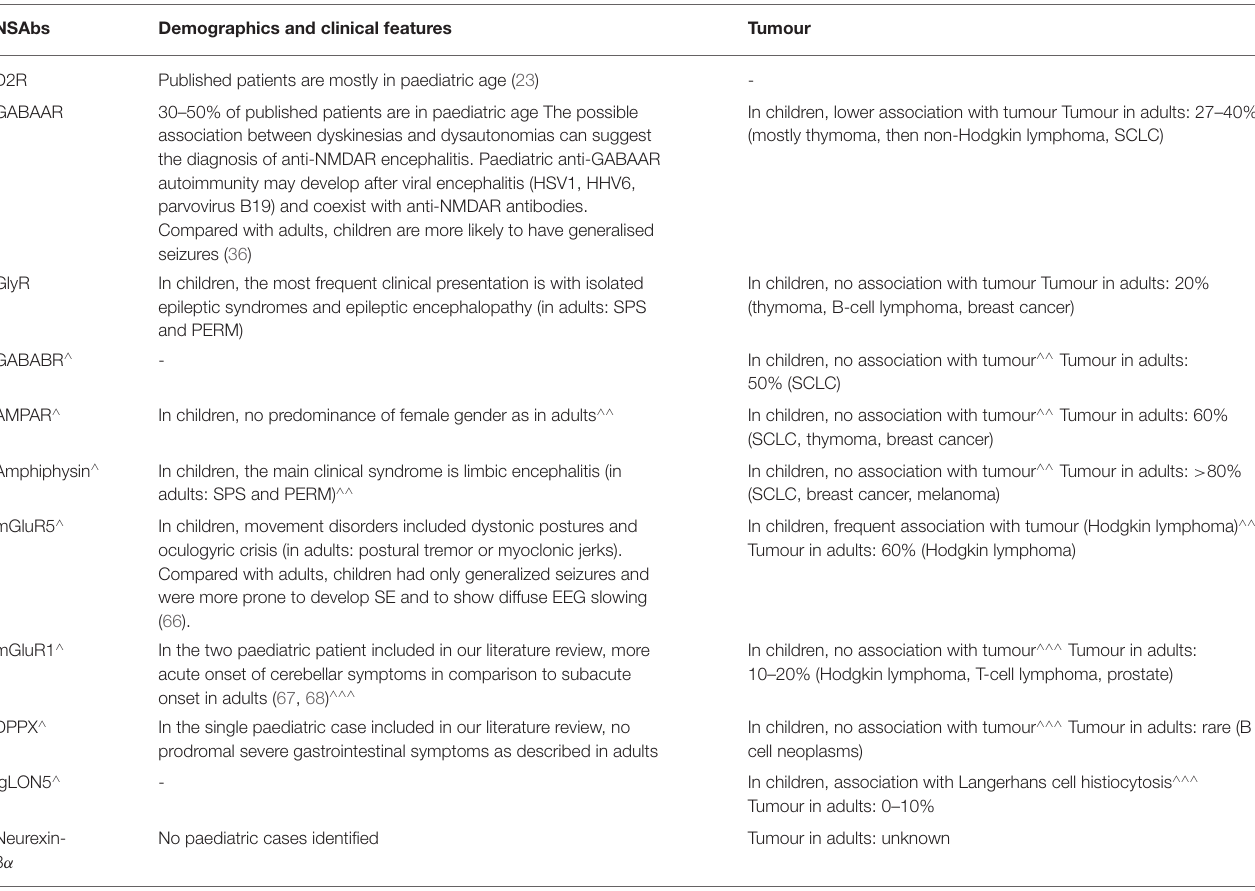
TABLE 2B | Rare NSAS (with antibodies targeting D2R, GABAAR, GlyR, GABABR, AMPAR, amphiphysin, mGluR5, mGluR1, DPPX, IgLON5, and neurexin-3alpha): main distinctive features in paediatric age compared to adults, as regards demographics, clinical features and association with tumour, based on our systematic literature review and on previous literature observations (3, 4, 23, 36,